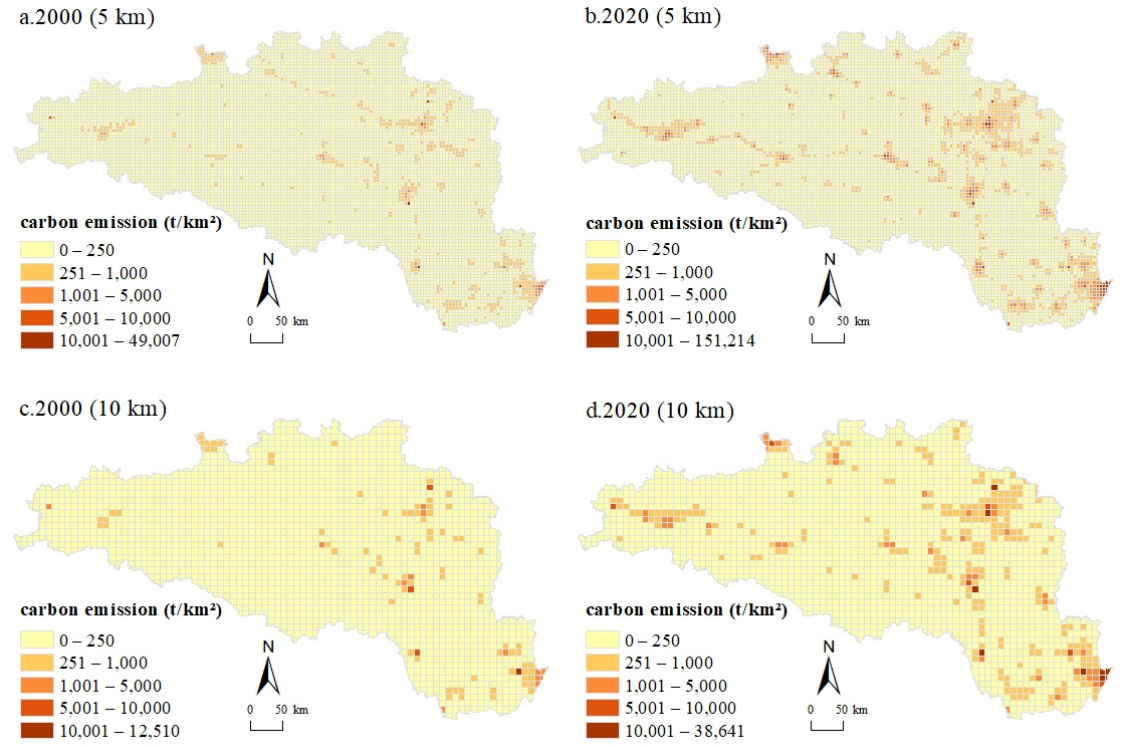
Figure 2. Spatiotemporal patterns of CEs at 5 km and 10 km grid scales in 2000 and 2020 in the